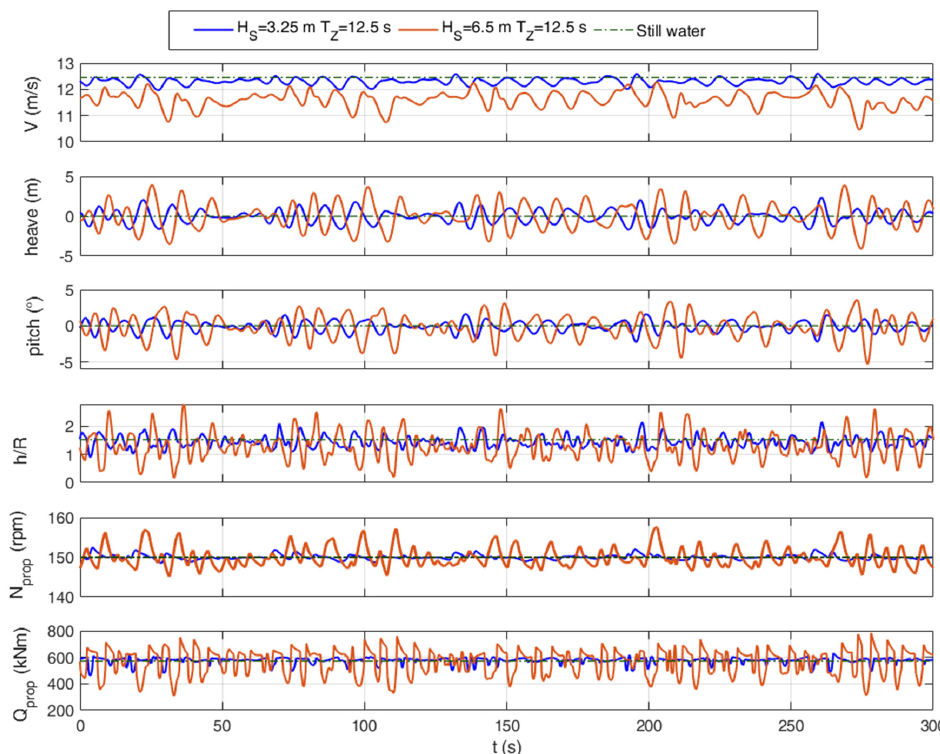
Figure 3. Time history of ship dynamics and propeller behavior in a head sea, for two proportional irregular sea states and still water.